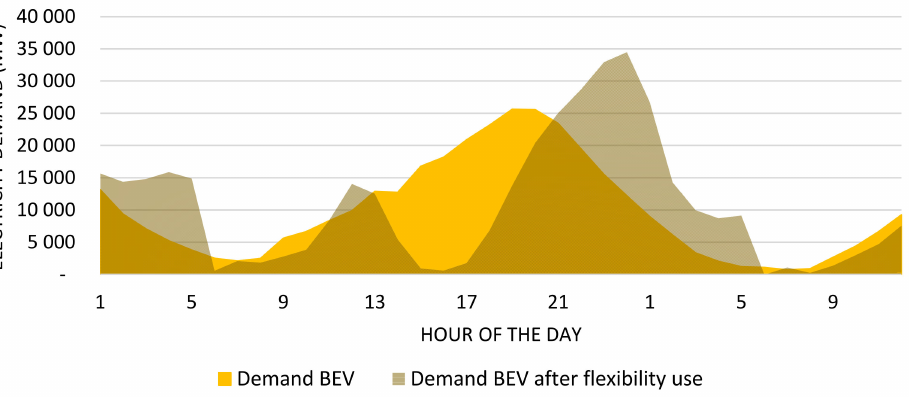
Figure 7. Electricity demand due to the BEV -charging process before (yellow) and after the flexibility use (brown, transparent) for an exemplary